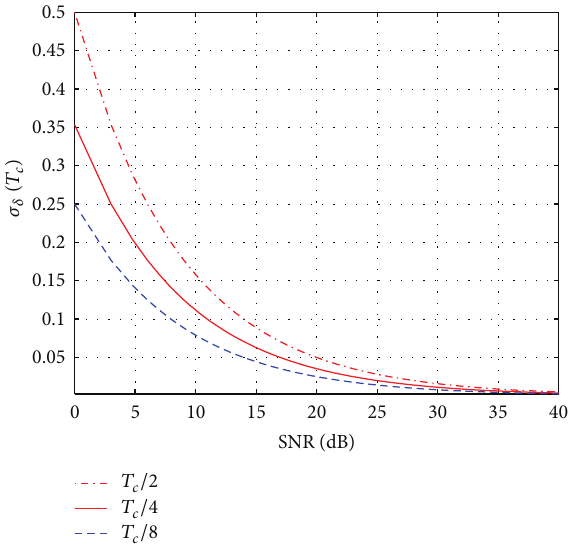
Figure 6: Tracking performance of the DLL versus SNR.